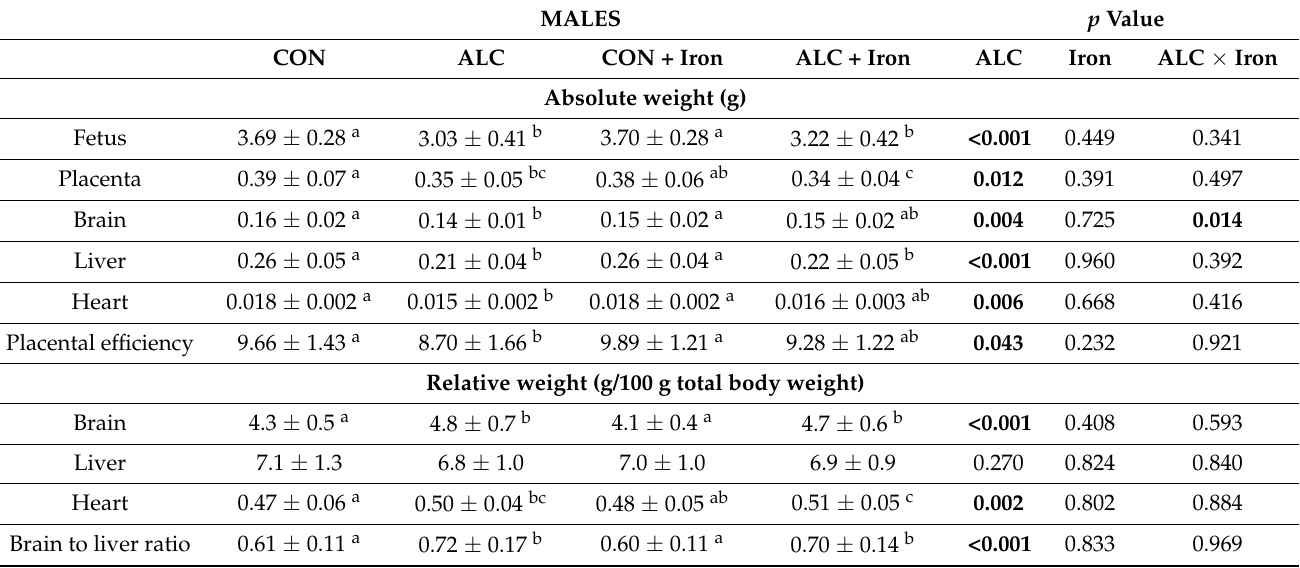
Table 2. In male fetuses, alcohol exposure reduced absolute fetal and organ weights and increased relative weights of brain and heart, while iron improved absolute brain weight.